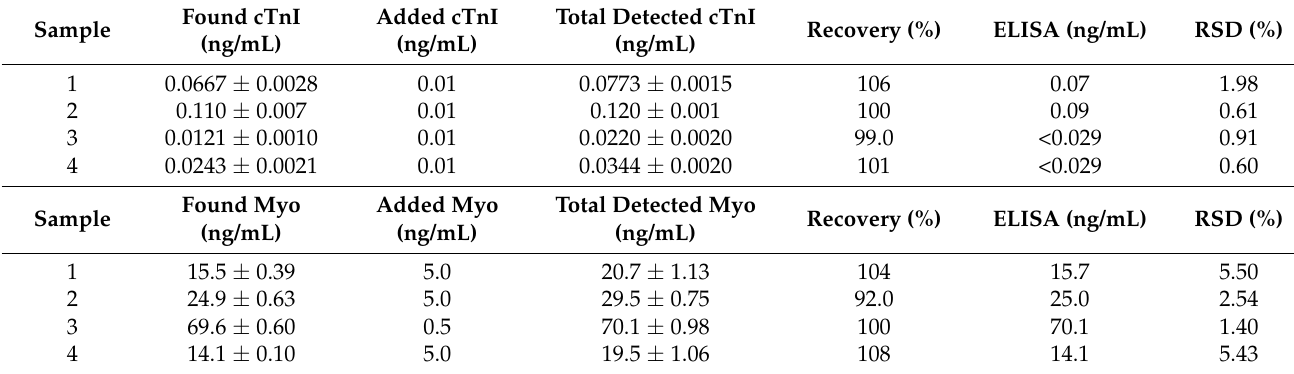
Table 2. Quantitative results of cTnI and Myo in human serum